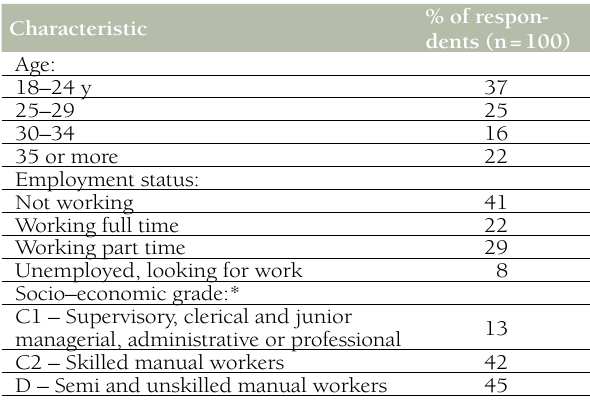
Table 1. Percentage distribution of respondents by demographic characteristics